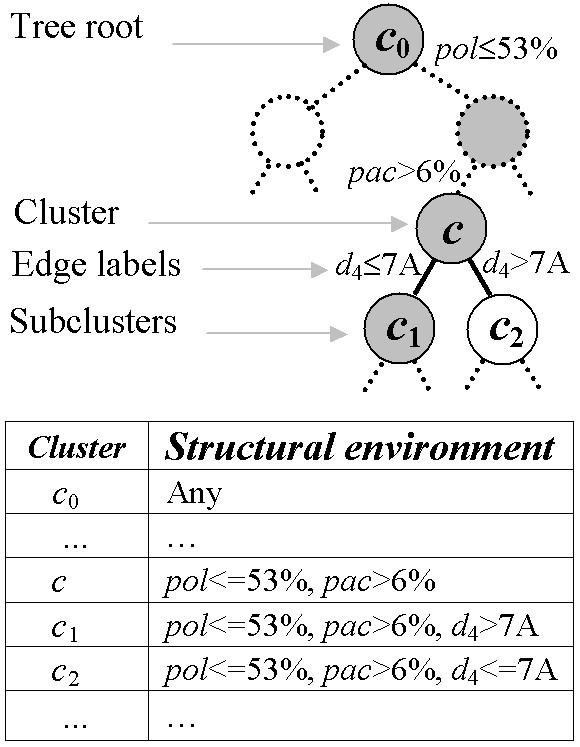
Decision tree classification of all observed substitutions for Leucines. Similar trees are built for each of the 21 residue types, including half-cystine. The structural environment for a given cluster is defined by the edge labels along its path from the root cluster c0. For example, the nodes colored in gray indicate the partial classification path of a Leucine observed in a native structural environment whose descriptors s23, s15 and s10 verify s23 = pol = 3%, s15 = pac = 7% and s10 = d4 = 5.4A.